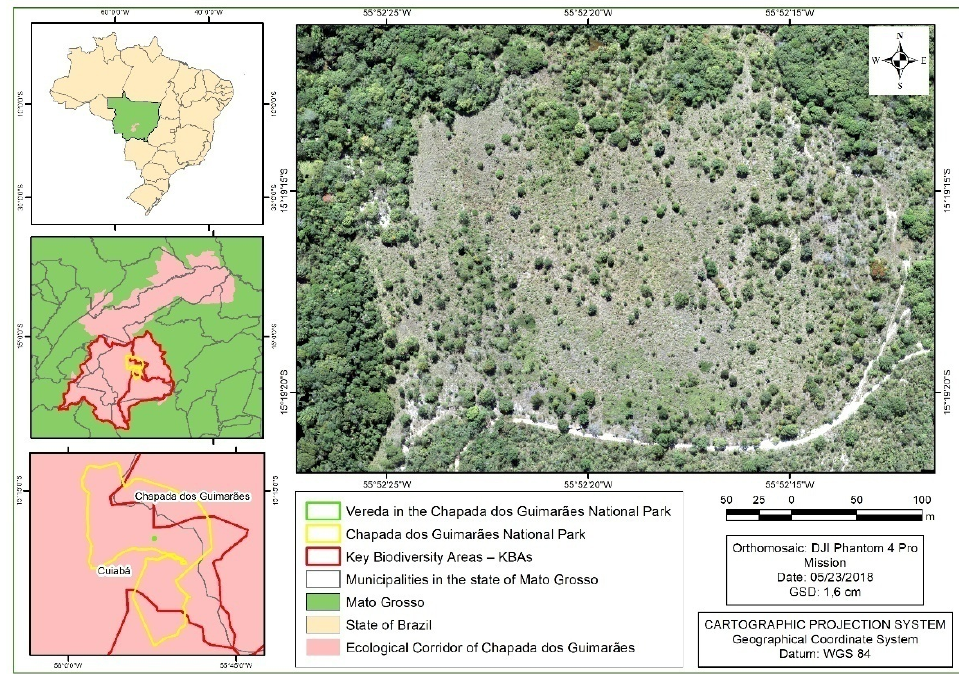
Figure 1. Location of the study area.